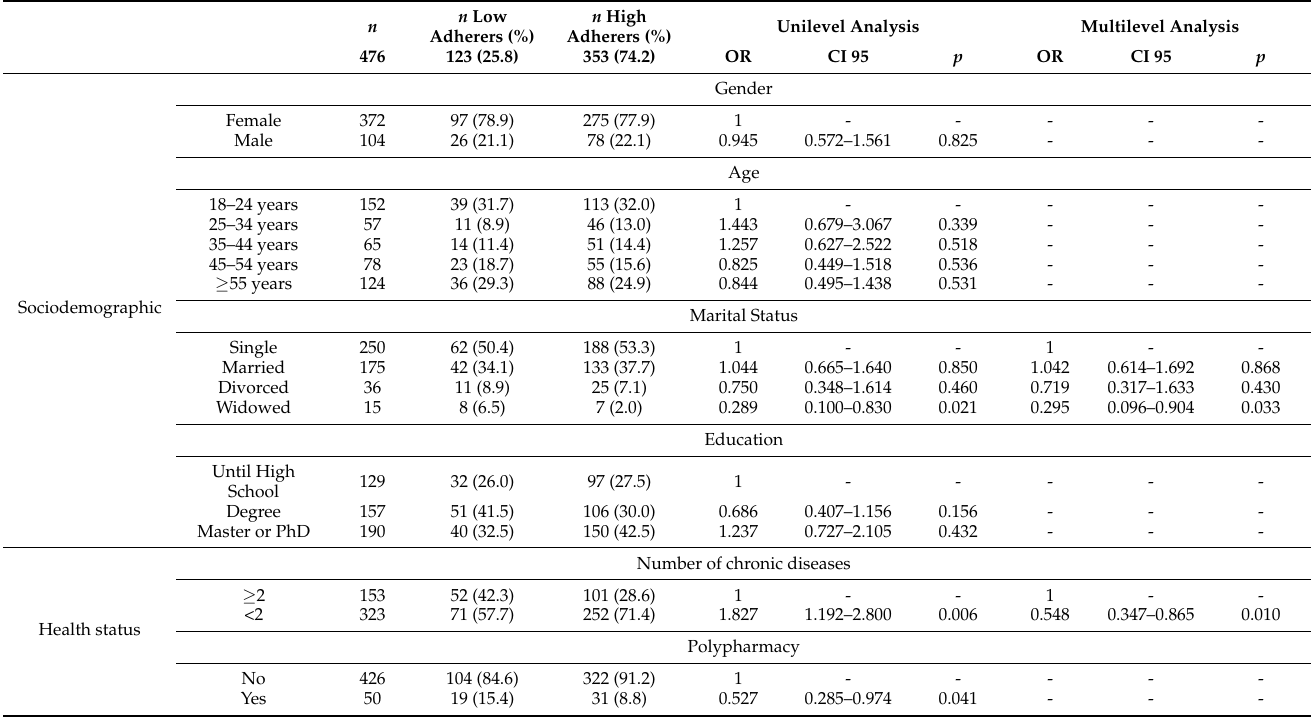
Table 3. Association of sociodemographic, health status, COVID-19 impact on medication adherence, COVID-19 impact on adherence to healthy lifestyles, and COVID-19 perceptions and impact on daily life with adherence: univariate and multivariate